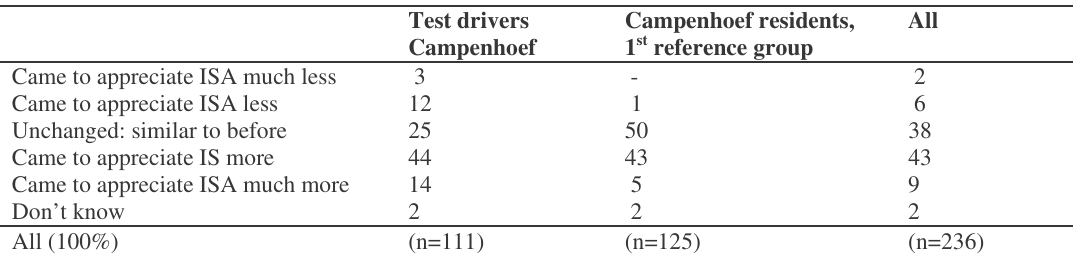
Table 4. Development of attitude towards ISA after ISA experience (% of